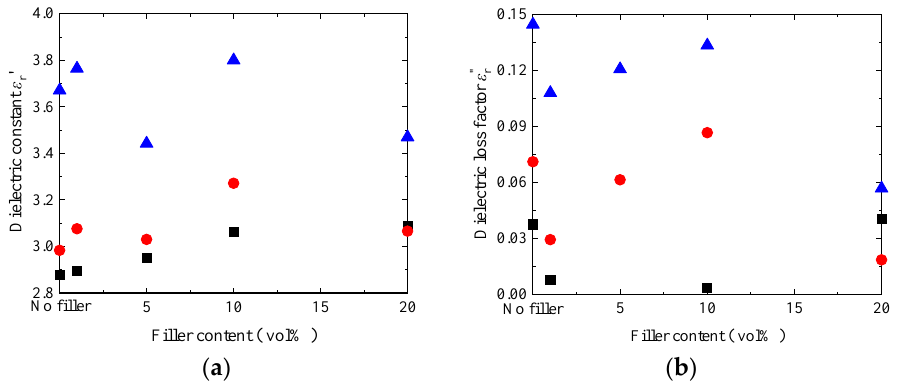
Figure 4. ε r ′ ( a ) and ε r ″ ( b ) as a function of filler content, measured in epoxy NC samples with 100- Figure 4. ε r (cid:48) ( a ) and ε r ” ( b ) as a function of filler content, measured in epoxy NC samples with 100-nm nm silica at 20 ( ■ ), 100 (●), and 140 ( ▲ ) °C. silica at 20 ( (cid:4) ), 100 ( • ), and 140 ( (cid:78) ) ◦ C.